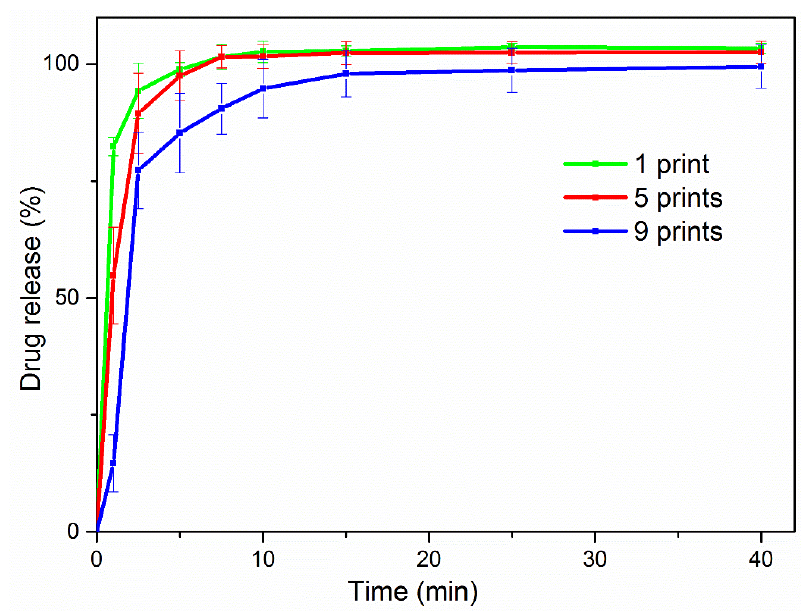
Figure 7. Release profiles of the developed formulations in simulated saliva. Table 3. Curve fitting parameters.